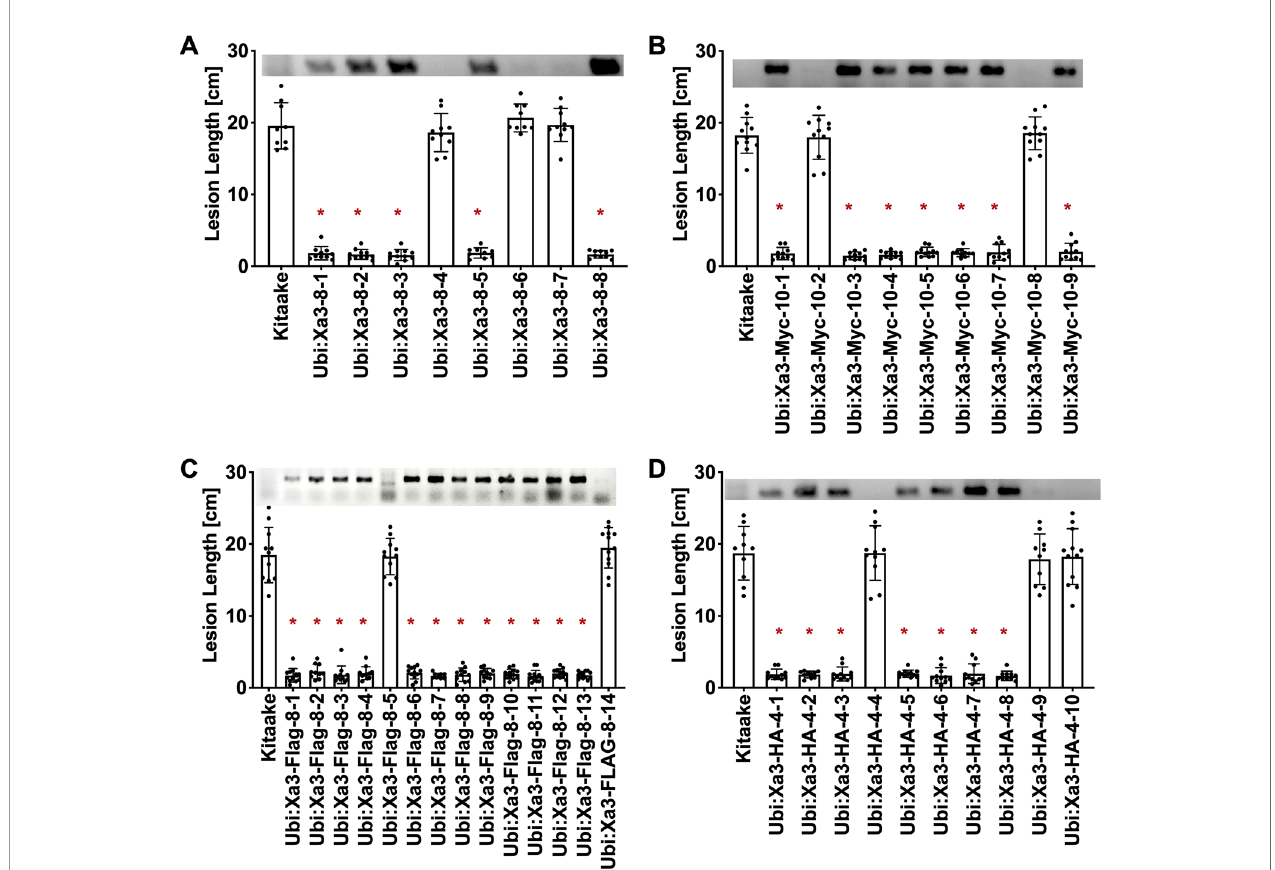
FIGURE 2 | Resistance to Xoo strain PXO79 cosegregates with the Xa3 transgene in the T1 progeny. Rice lines expressing Xa3 are resistant to Xoo infection. The inoculation method was described in Figure 1 . Bars represent means of 8 – 12 leaves. “ * ” indicates a statistically signi fi cant difference from Kitaake using Dunnett ’ s test ( a = 0.05). The upper panel in each fi gure is genotyping data for the Xa3 transgene by PCR using the forward primer annealing to the Xa3 gene and the reverse primer annealing to the vector. (A) Lesion length data for eight Ubi : Xa3 T1 plants. (B) Lesion length data for nine Ubi : Xa3 :Myc T1 plants. (C) Lesion length data for fourteen Ubi : Xa3: Flag T1 plants. (D) Lesion length data for 10 Ubi : Xa3 :HA T1